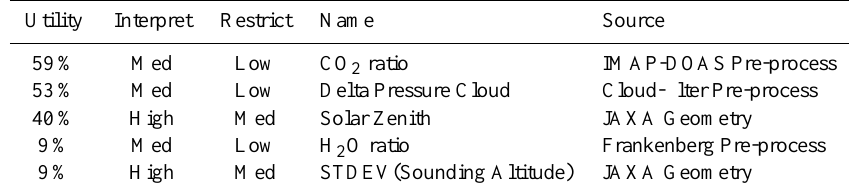
Table 2. Features chosen by the genetic algorithm to reduce scatter over Land (Nadir mode). Utility